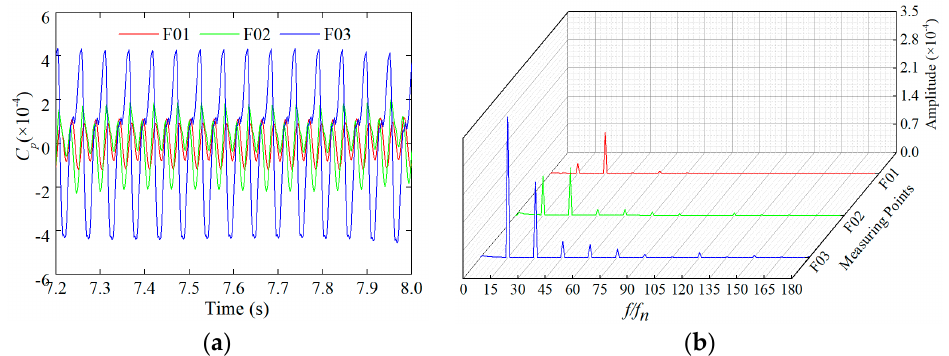
Figure 6. Time and frequency analysis of C p at the measuring points F01~F03. ( a ) Time domain graph, ( b ) frequency domain graph.